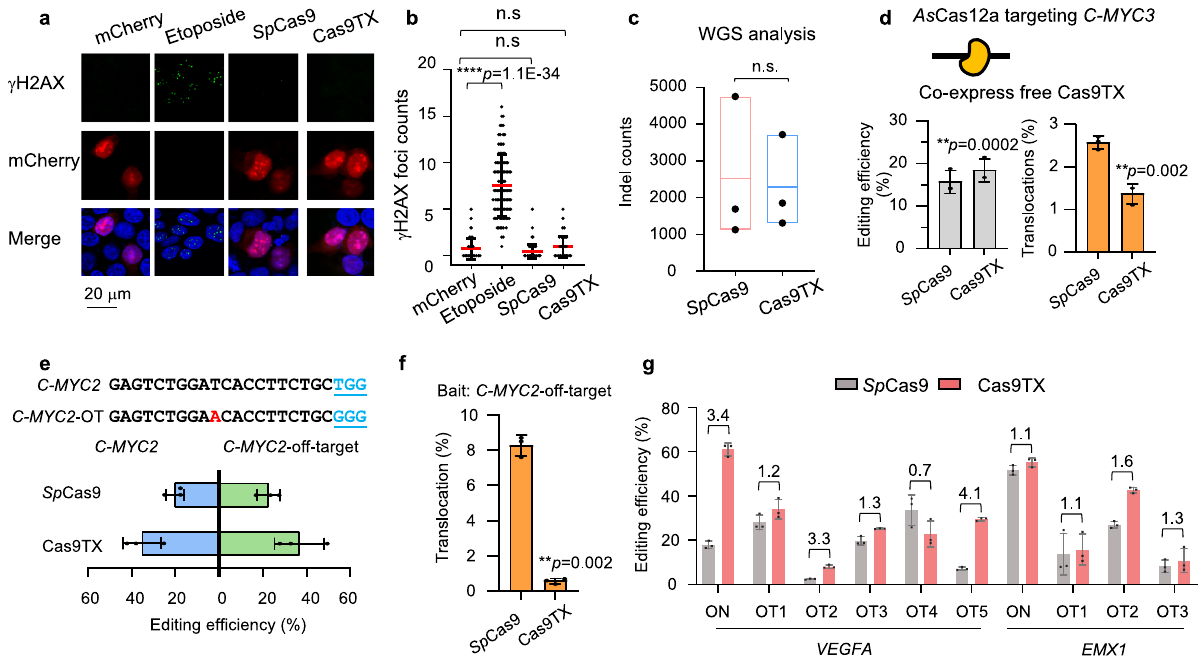
Fig. 6 Effect of Cas9TX on genome stability. a Immuno fl uorescence for γ H2AX in HEK293T cells treated with etoposide, Sp Cas9, or Cas9TX. Images were taken 24 h after transfection by confocal microscopy. Both Sp Cas9 and Cas9TX were expressed with a P2A-mCherry tag. mCherry alone was the negative control. b Statistics for γ H2AX foci in each HEK293T cell treated with etoposide, Sp Cas9, or Cas9TX. N = 100 cells were analyzed for each group, two- tailed t -test, **** p < 0.00001; n.s, no signi fi cance. c Indel counts for Cas9-edited and Cas9TX-edited mESCs by WGS analysis. Three biological replicates, two-tailed t -test. n.s means no signi fi cance. Values from minimum to maximum are shown in the box. The line represents the average. d The impacts of Sp Cas9 and Cas9TX on the editing ef fi ciency and translocation levels of As Cas12a: C-MYC3 detected by PEM-seq in HEK293T cells. Mean ± SD from three biological replicates. Two-tailed t -test, ** p < 0.01. e Editing ef fi ciency for Sp Cas9 and Cas9TX at C-MYC2 and the identi fi ed C-MYC2 off-target site detected by PEM-seq in HEK293T cells. Mean± SD from three biological replicates. Two-tailed t -test, ** p < 0.01. DNA sequences for C-MYC2 and the C-MYC2 off- target are shown at the top. Mismatched DNA is in red. f Percentages of translocations cloned from the C-MYC2 off-target site by PEM-seq in HEK293T cells. Mean ± SD from three biological replicates. Two-tailed t -test, ** p < 0.01. g Editing frequency of Sp Cas9 and Cas9TX at the on-targets and off-targets of VEGFA and EMX1 identi fi ed by PEM-seq analysis in Figs. 3 and 4. Primers were designed at off-target sites with PCR ampli fi cation. Editing ef fi ciency was evaluated by TIDE. Fold changes for Cas9TX to Sp Cas9 are at the top. Mean ± SD from three replicates. Source data are provided as a Source Data fi